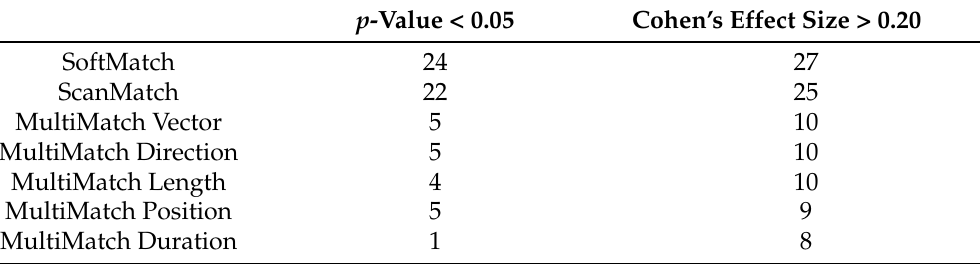
Table 1. Total results (out of 30) for each method where p -values are over 0.05 and Cohen’s effect size is over 0.20. Please see Appendix A for a detailed p -value matrix. p -Value <